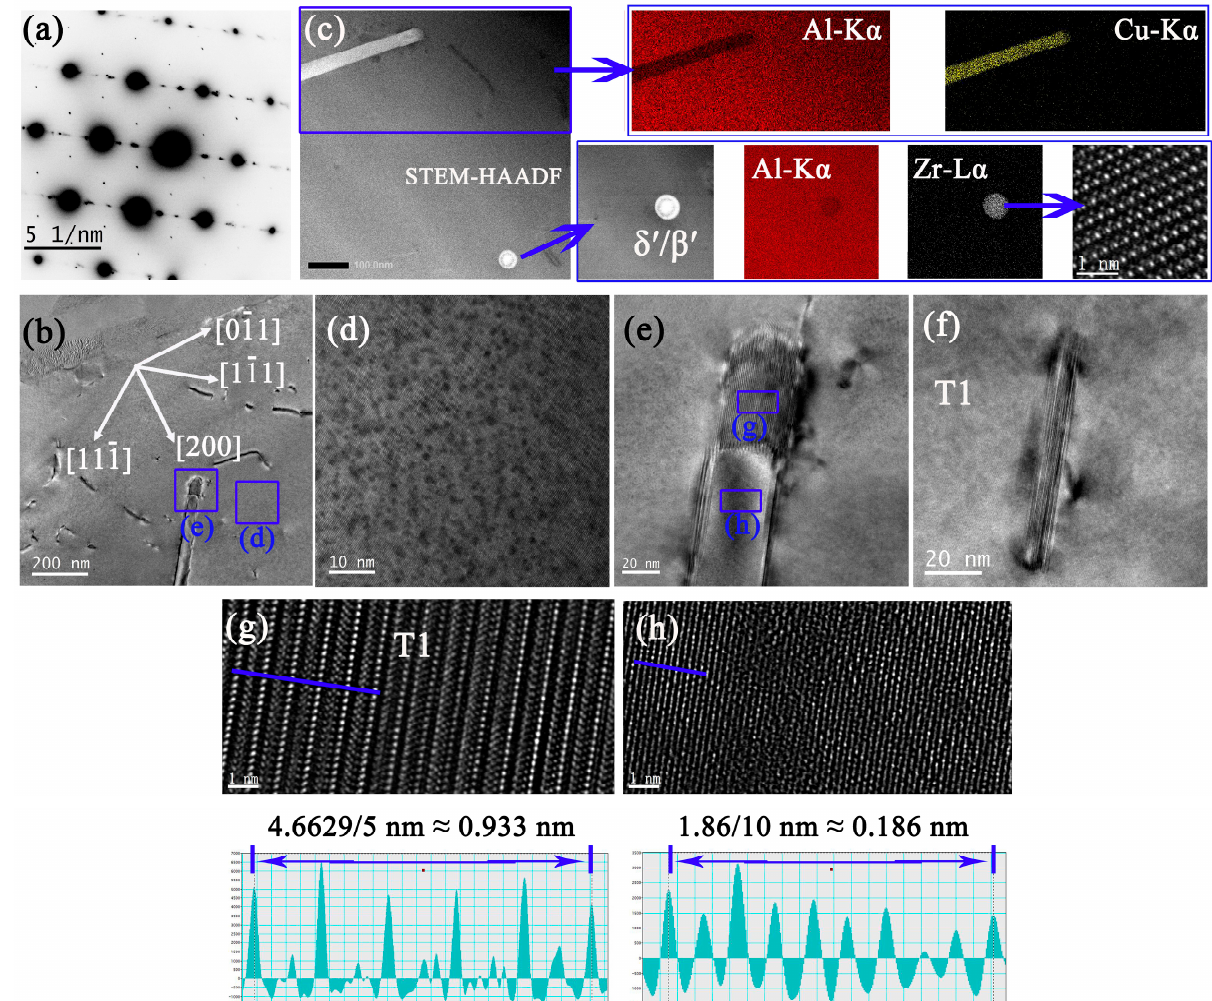
Figure 12. TEM analysis of 3A# after 12 h creep. ( a ) SADP under [110] α . ( b ) BF, ( c ) HAADF, and EDS mapping of the same area of ( b ) in STEM mode. ( d , e ): enlarged BF in ( b ). ( f ) BF of a single secondary T 1 phase. ( g , h ) HRTEM images in ( e ).